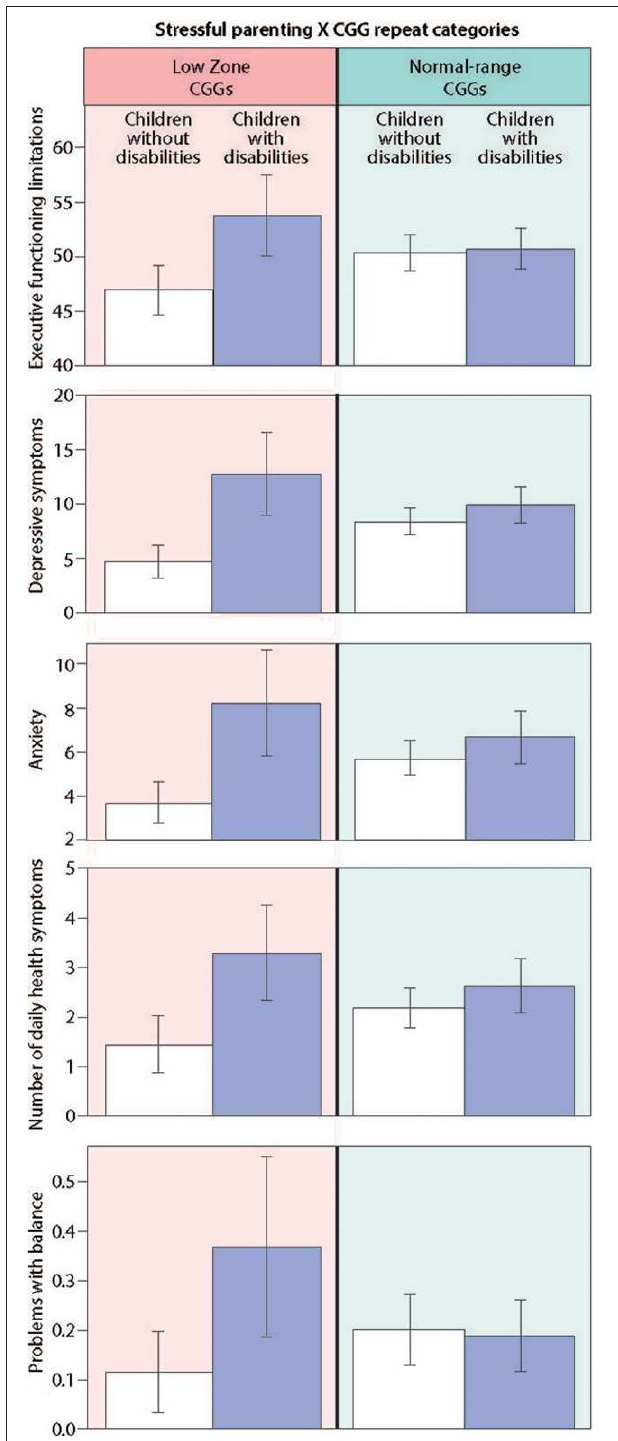
FIGURE 2 | Significant interaction effects of stressful parenting status by CGG repeat category.